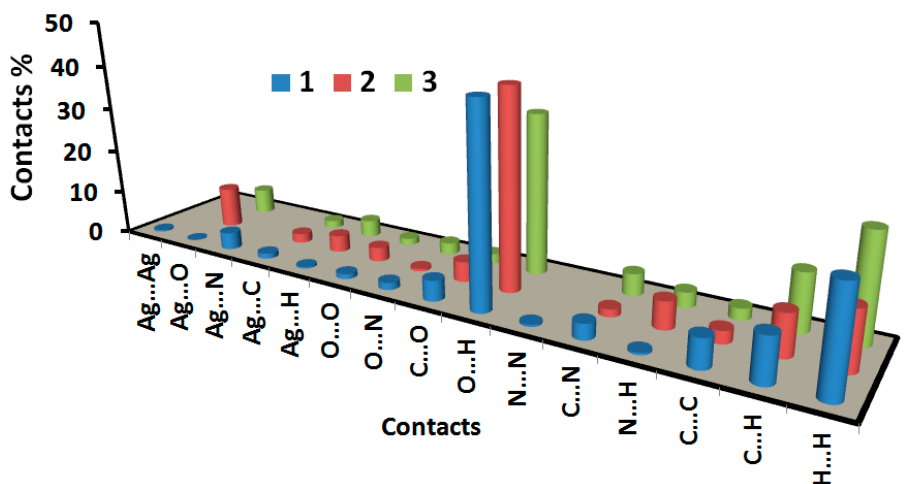
Figure 7. Different contacts in [Ag(pyridine-3-carboxaldhyde) 2 NO 3 ]; ( 1 ), [Ag 3 (2-pyridone) 3 (NO 3 ) 3 ]; ( 2 ) and [Ag(3-hydroxypyridine) 2 ]NO 3 ; ( 3 ) complexes.